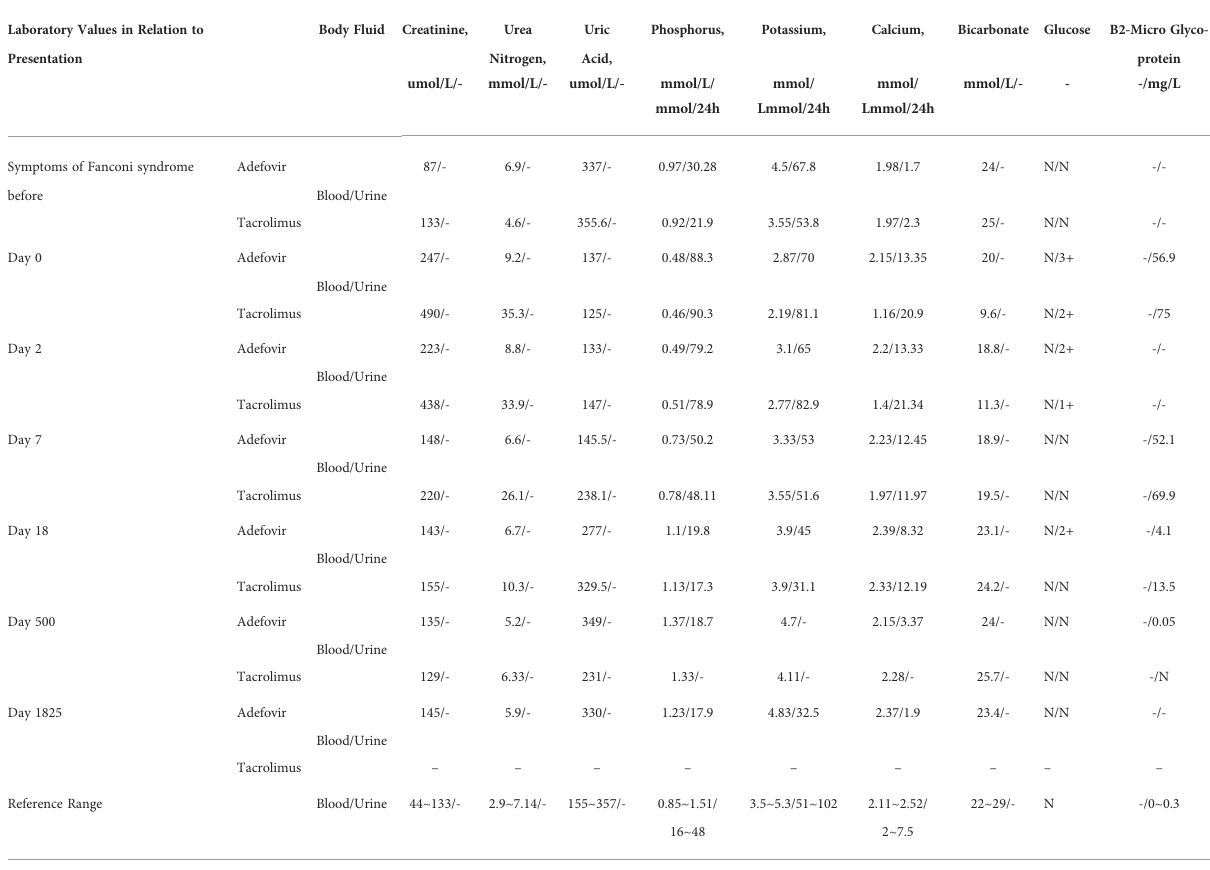
TABLE 2 Laboratory Values in Relation to